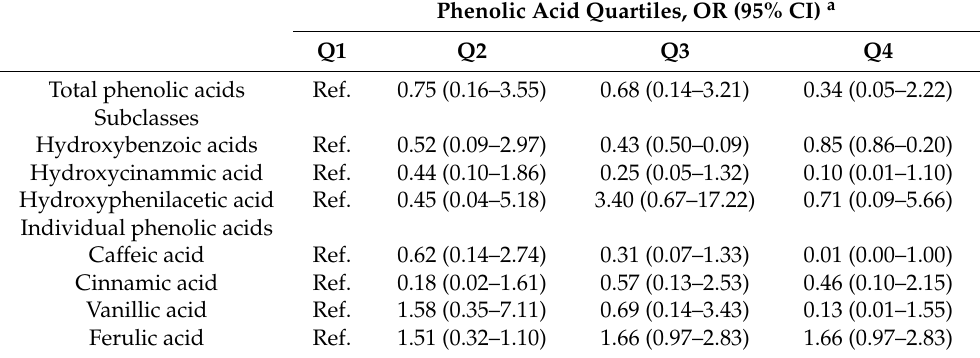
Table 4. Association between quartiles of total, subclasses and individual phenolic acid intake and advanced prostate